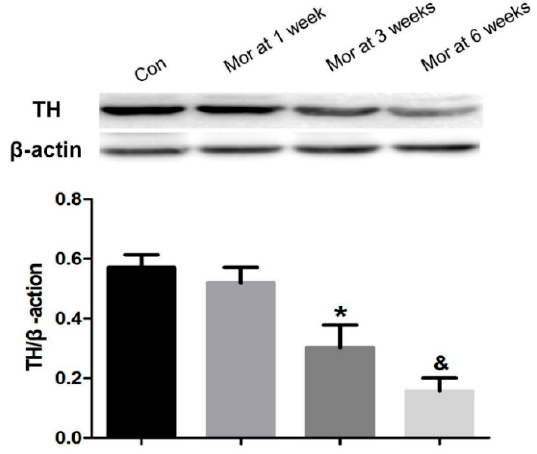
Figure 3. Western blotting analysis shows the expression of TH in the VTA. The expression of TH significantly decreased after three and six weeks of morphine dependence. Data are presented as the mean ± SEM ( n = 4). * P < 0.05, & P < 0.01 vs. control group.